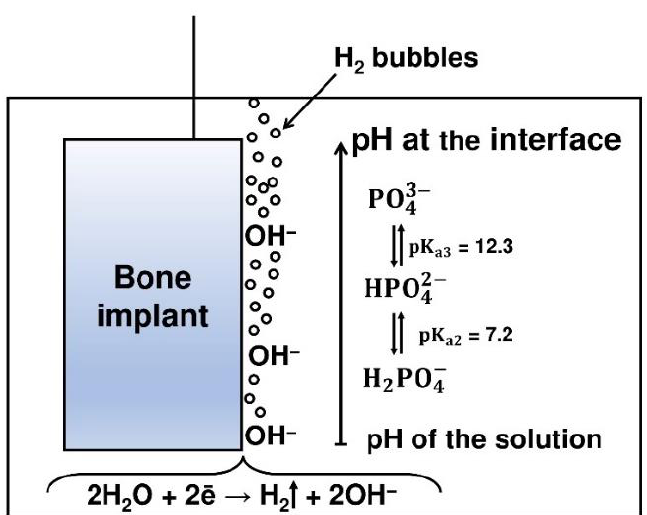
Figure 3. Sketch of the cathode-electrolyte interface during deposition. The concentration of phosphate species as a function of the pH of the solution is shown in Figure 4.